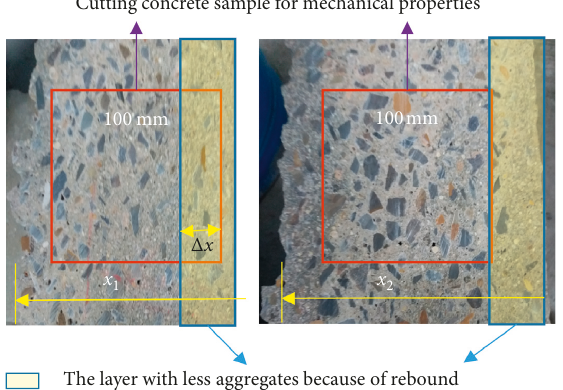
The layer with less aggregates because of Figure 16: Cutting lines of thin and thick shotcrete layers for standard concrete specimens.